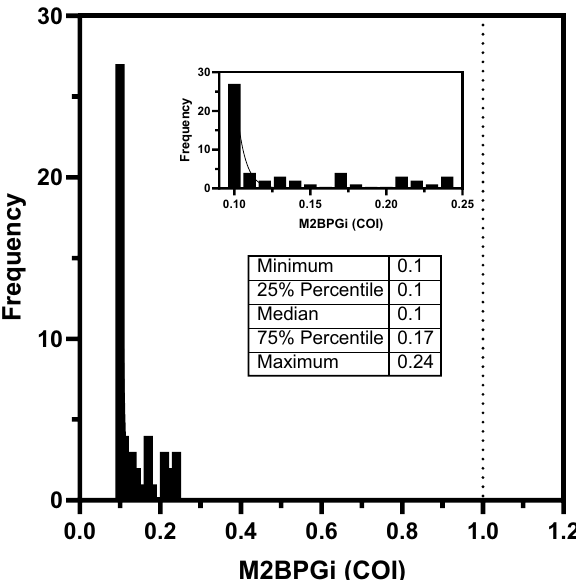
Figure 2. M2BPGi levels among healthy volunteers which is significantly below the cutoff (1.0 COI) recommended by the manufacturer for positive results.